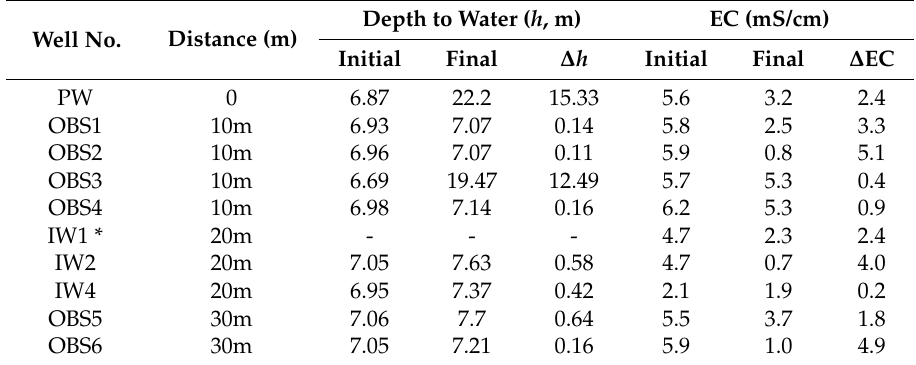
Table 3. Groundwater levels and EC values at 25-m depth at the wells during the pumping test. Depth to Water ( h , m) EC (mS/cm) Well No. Distance (m) Initial Final ∆ h Initial Final ∆ EC